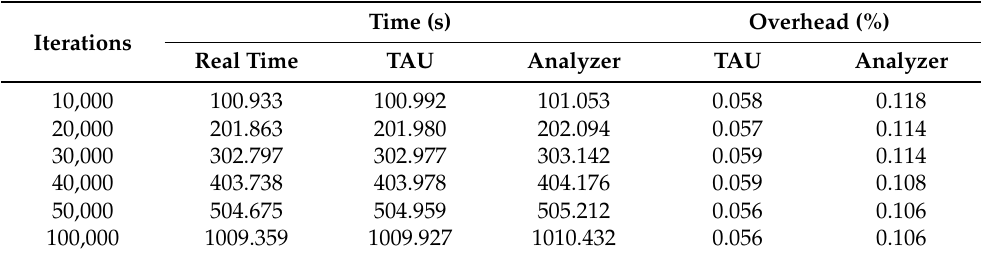
Table 1. Instrumentation overhead estimation varying the number of samples collected for TAU and